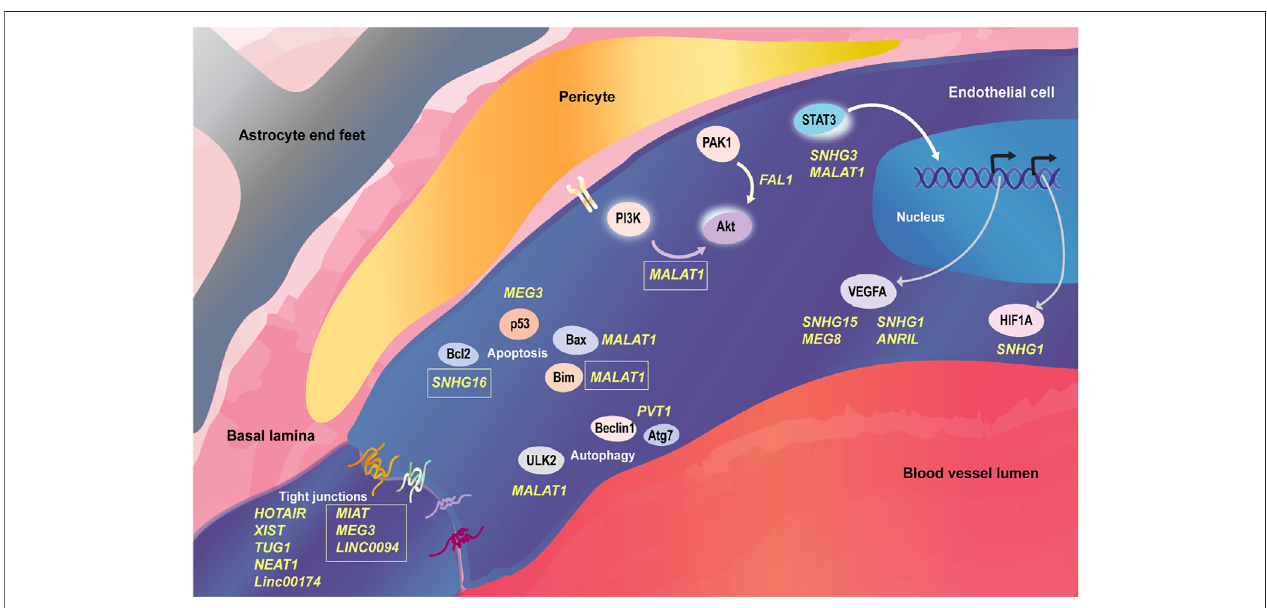
FIGURE 1 | LncRNAs regulating cellular processes in cerebrovascular endothelial cells. The cerebrovascular endothelial cells of the neurovascular unit are governed by signaling pathways that respond to distinct cues from luminal and abluminal sides. Several lncRNAs have been discovered to regulate the protein coding geneplayersincerebrovascularendothelialcellsatpost-transcriptionalandpost-translationallevelswithinthesignalinginvolvingtightjunctionturnover,VEGFpathway, PI3K-Akt pathway, STAT3 activation, autophagy and apoptosis. LncRNAs are mentioned in yellow font in the fi gure; the ones in boxes negatively regulate their cognate pathways, while the rest have a positive role in their cognate pathways. All the references to the mentioned lncRNAs can be found in Table 1